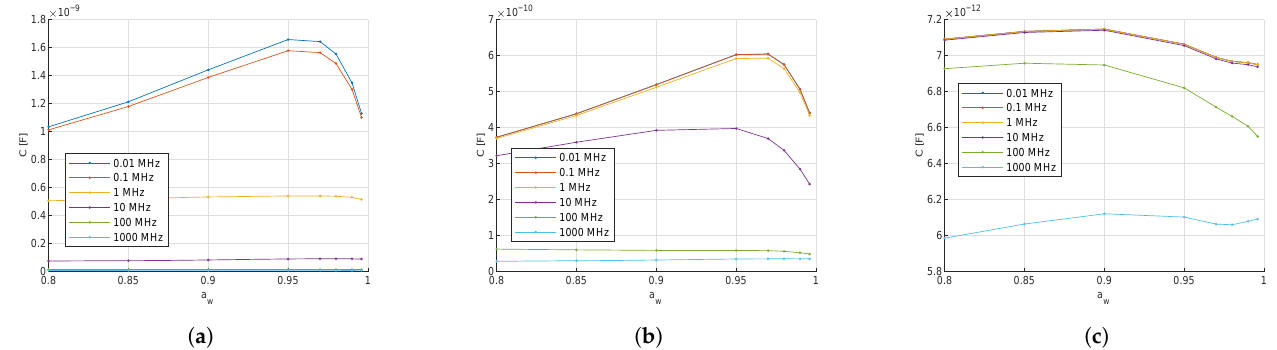
Figure 5. Simulated capacitance of the three electrode types at logarithmically spaced frequencies from 10kHz to 1GHz. The dimensions of the skin are for the epidermis/dermis 1mm and the hypodermis 2mm. The dry SC thickness in (9) is set to 9.55µm. The dispersive dielectric behavior is visible with the capacitance reducing with increasing frequency. ( a ) Circular conductance electrode. ( b ) Interdigitated conductance electrode. ( c ) Interdigitated capacitance